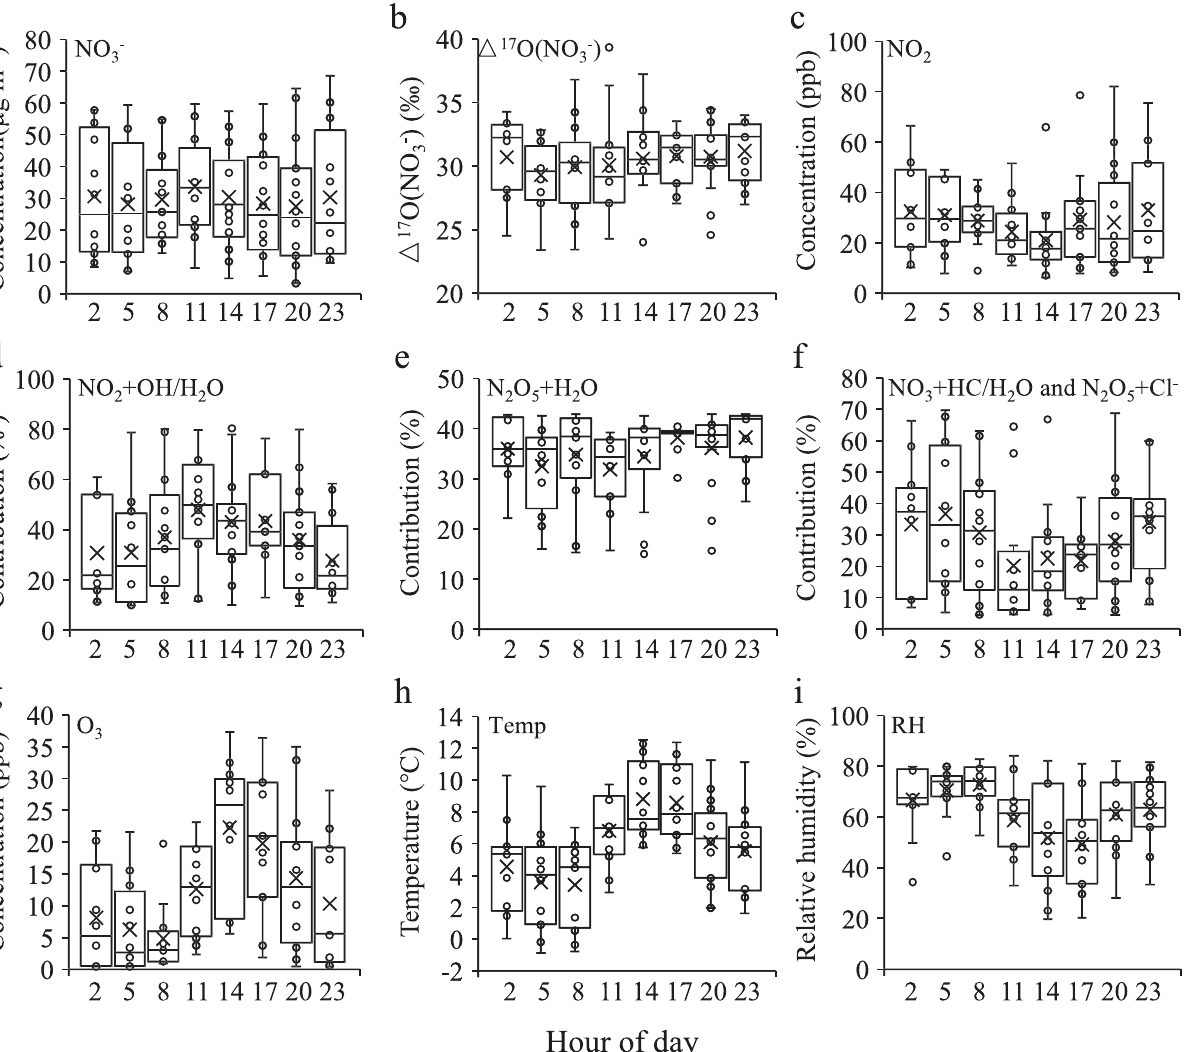
Fig. 4 Diurnal variations of nitrate formation pathways. The changes in a mass concentrations of nitrate ( NO (cid:1) of nitrate ( Δ 17 O( NO (cid:1) )), c mass concentrations of nitrogen dioxide (NO 2 ), d – f the relative contributions of three pathways (pathway 1: NO 2 + 3 OH/H 2 O, pathway 2: N 2 O 5 + H 2 O and pathway 3: NO 3 + HC/H 2 O and N 2 O 5 + Cl − ) to nitrate production, g mass concentrations of ozone (O 3 ), h ambient temperature (temp) and i relative humidity (RH) throughout the day during the sampling period. The mean (cross), median (horizontal line), 25th and 75th percentiles (lower and upper box), and 10th and 90th percentiles (lower and upper whiskers) are shown in each